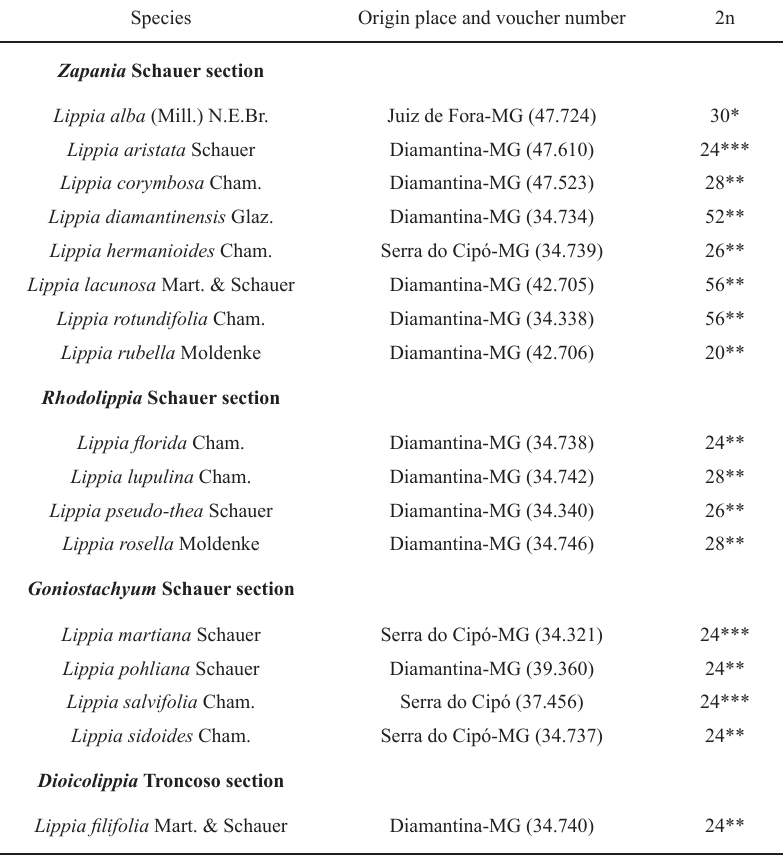
Origin, voucher number and chromosome number of 17 Lippia